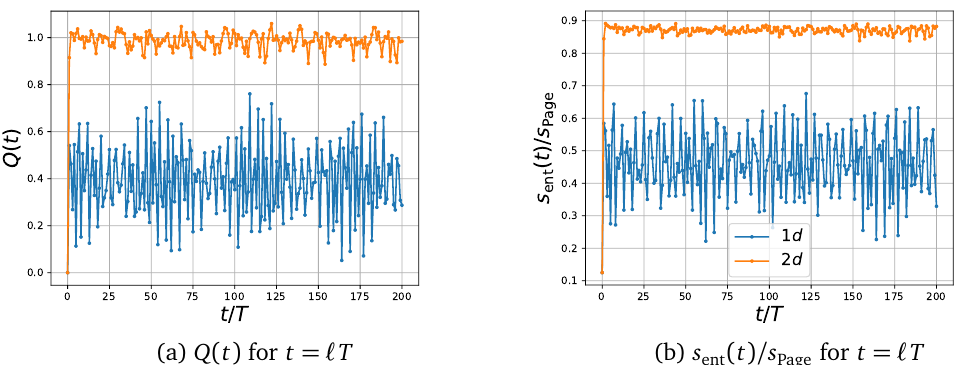
( t ) (b) for 1 d (orange) and ent is ent